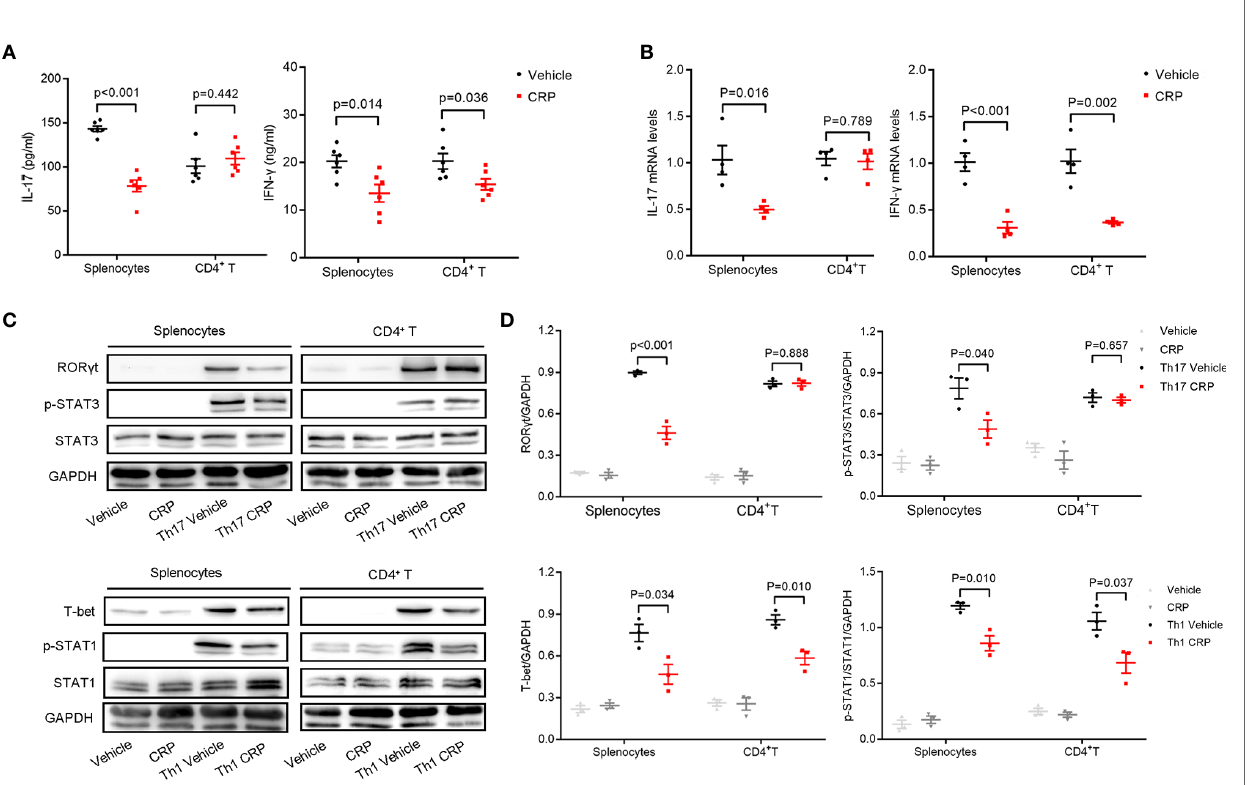
FIGURE 2 | CRP reduces Th17 responses in splenocytes from WT mice.Splenocytes and CD4 + T cells were isolated from WT mice to distinguish the indirect and direct regulations of CRP on Th17. (A) The protein expression levels of IL-17 and IFN- g were measured with CRP treatment in both splenocytes and CD4 + T cells by ELISA (n = 6). (B) The mRNA expression levels of IL-17 and IFN- g were measured with CRP treatment in both splenocytes and CD4 + T cells by qPCR (n = 4). (C) Splenocytes and CD4 + T cells were cultured with CRP in Th17 and Th1 polarization conditions, then ROR g t, T-bet, p-STAT-3, and p-STAT-1 were examined by WB. (D) The quantitative and statistical analysis of the WB results was presented (n = 3). Data are presented as mean ± SEM; p < 0.05 was considered statistically signi fi